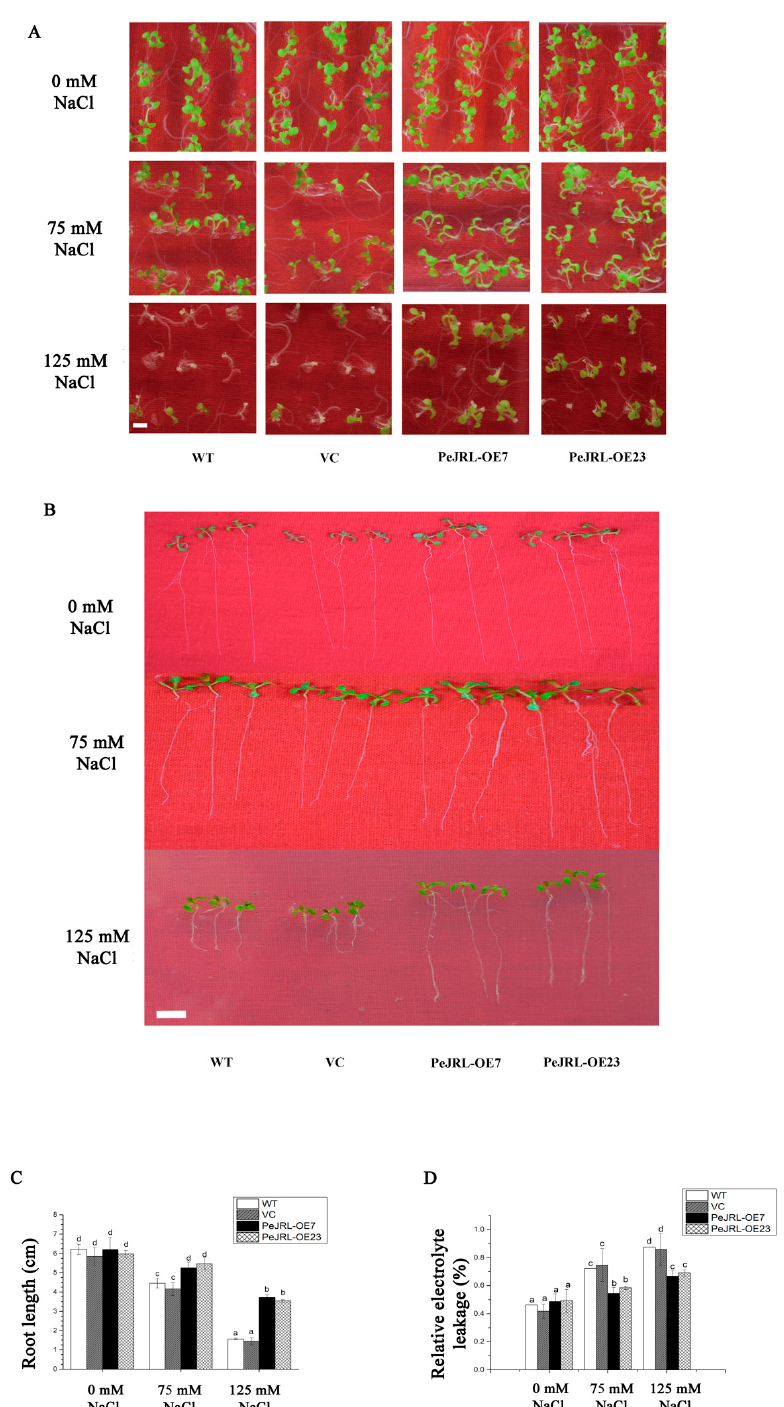
Figure 5. Salt tolerance tests in WT, VC, and PeJRL -transgenic Arabidopsis lines (OE7 and OE23). Seeds of WT, VC, and transgenic lines were allowed to germinate on 1/2 Murashige–Skoog (MS) medium supplemented with 0, 75 or 125 mM NaCl. Representative images show plant performance during seedling establishment ( A ) and root length ( B , C ) after 10 days of NaCl stress (0, 75 or 125 mM). Each column corresponds to the mean of three independent experiments (70 seeds for each test). ( D ) Relative electrolyte leakage. Electrolyte leakage was measured after 10 days of NaCl stress (0, 75 or 125 mM). Each column corresponds to the mean of three replicated experiments (20 seeds for each test) and bars represent the standard error of the mean. In C and D , columns labelled with different letters (a–d) denote significant differences at p < 0.05. Scale bar = 1 cm ( A , B